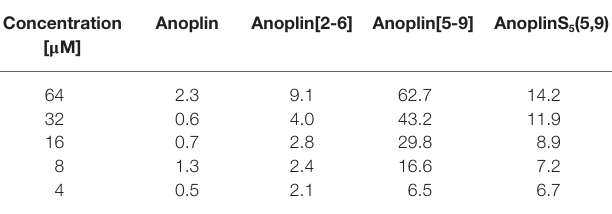
Erythrocytes treated with 1% Triton-X-100 were used as positive controls and set as 100%